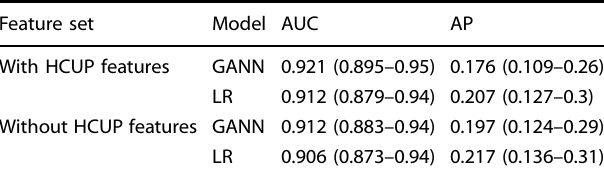
Table 3. Area under the receiver operating characteristic curve (AUC ROC) and average precision (AP) with 95% CIs for the Generalized Additive Models with Neural Networks (GAM-NNs) and logistic regression (LR) models, with and without HCUP category description